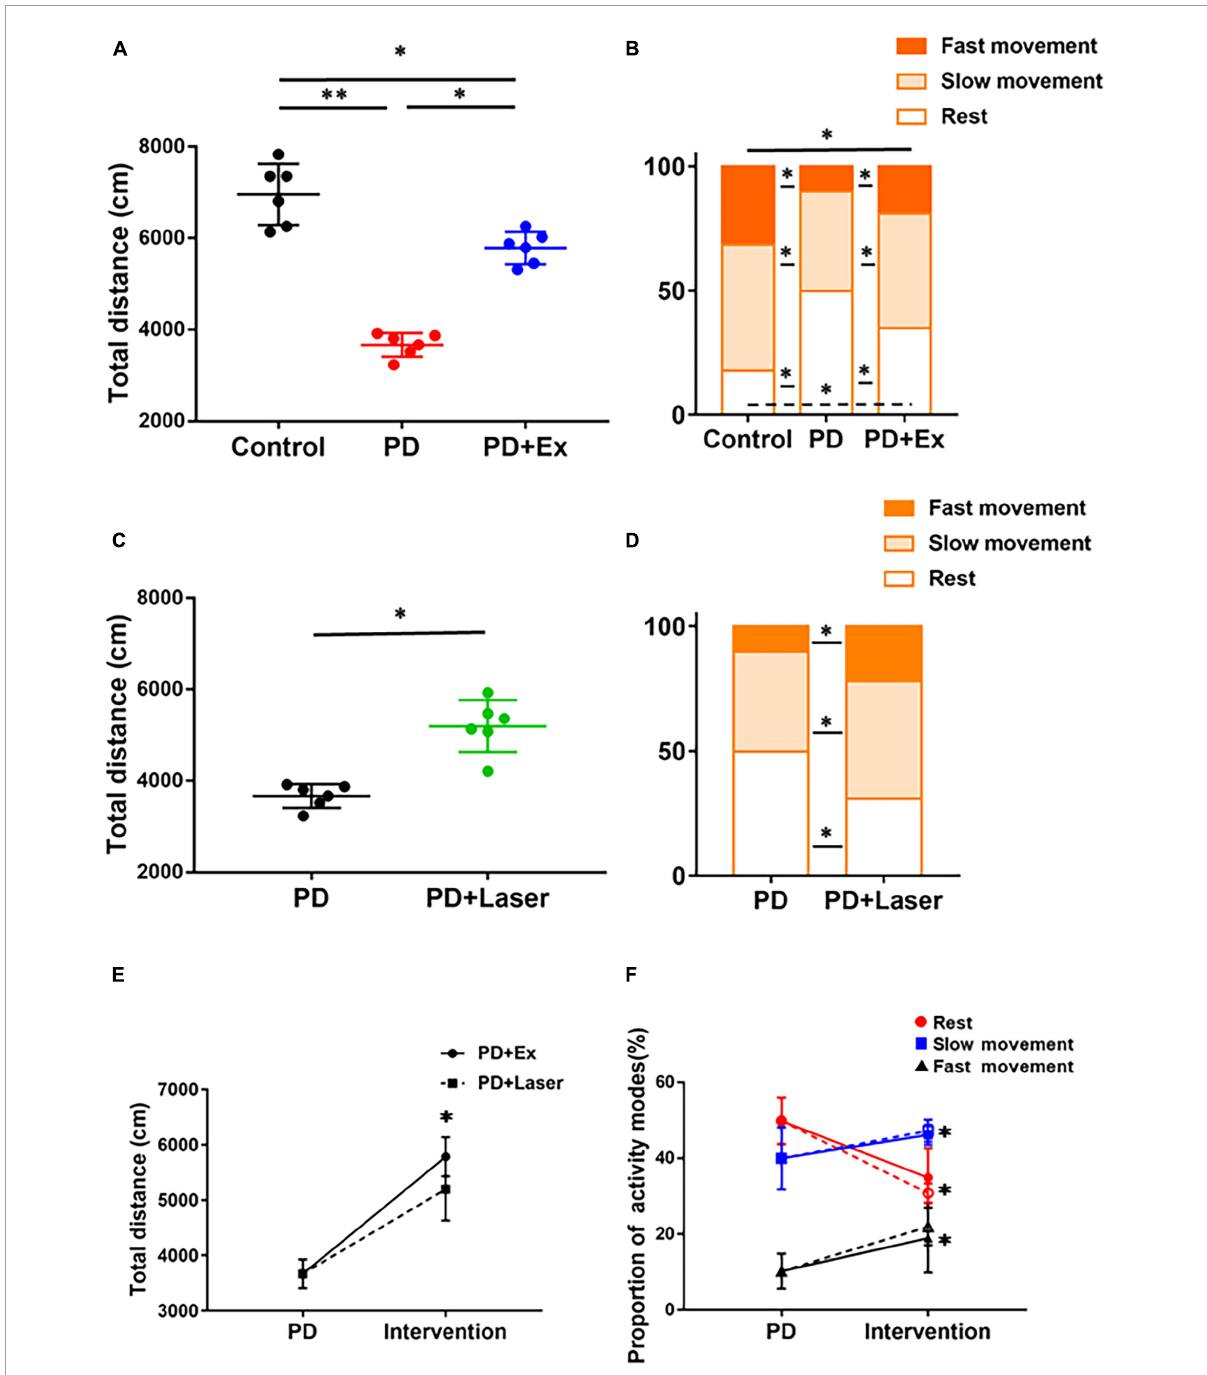
FIGURE8 Effects of intervention on autonomic mobility in mice. Total distance (A) and proportion of different activity modes after exercise (one-way ANOVA, p < 0.05) (B) . Total distance (C) and proportion of different activity modes (D) after optogenetic-stimulation (Student’s t -test, p < 0.05). Comparison of autonomic activity of PD mice after exercise and optogenetic-stimulation [solid line: PD + Ex; dotted line: PD + Laser, (E,F) ] (one-way ANOVA, p < 0.05). All data are showed as mean ± SEM. ∗ p < 0.05, ∗∗ p < 0.01.